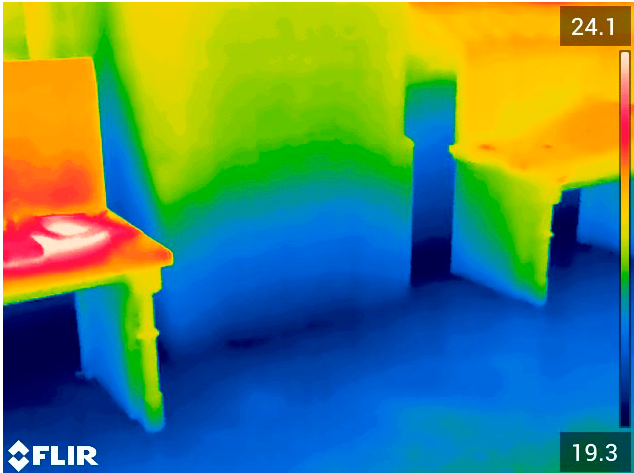
Figure 9. Thermal image of the tested